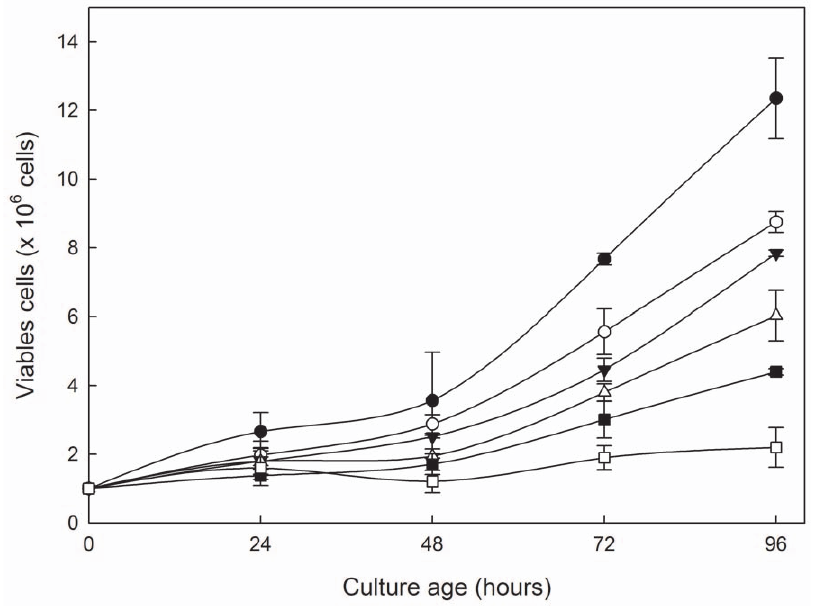
Figure 1. Growth of L.amazonensis cultivated in Schneider’s Drosophila medium at 26 6 C in the absence or in the presence of N Quercetin. L. amazonensis was cultivated in Schneider’s Drosophila medium at 26 u C as described in Materials and Methods for 96 h, in the absence ) or presence of 3 m M ( # ), 12 m M ( . ), 24 m M ( D ) 72 m M ( & ) or 96 m M ( % ) quercetin. The number of parasites was determined by direct counting ( with a Neubauer chamber. Values shown are the mean 6 standard error of three different experiments. In the control curve (absence of quercetin), the same volume of vehicle (DMSO 0.2%) was added to the growth medium. No differences were observed on lengths of flagella and cell body of promastigote in the presence of quercetin when compared with parasite growth in the absence of quercetin.